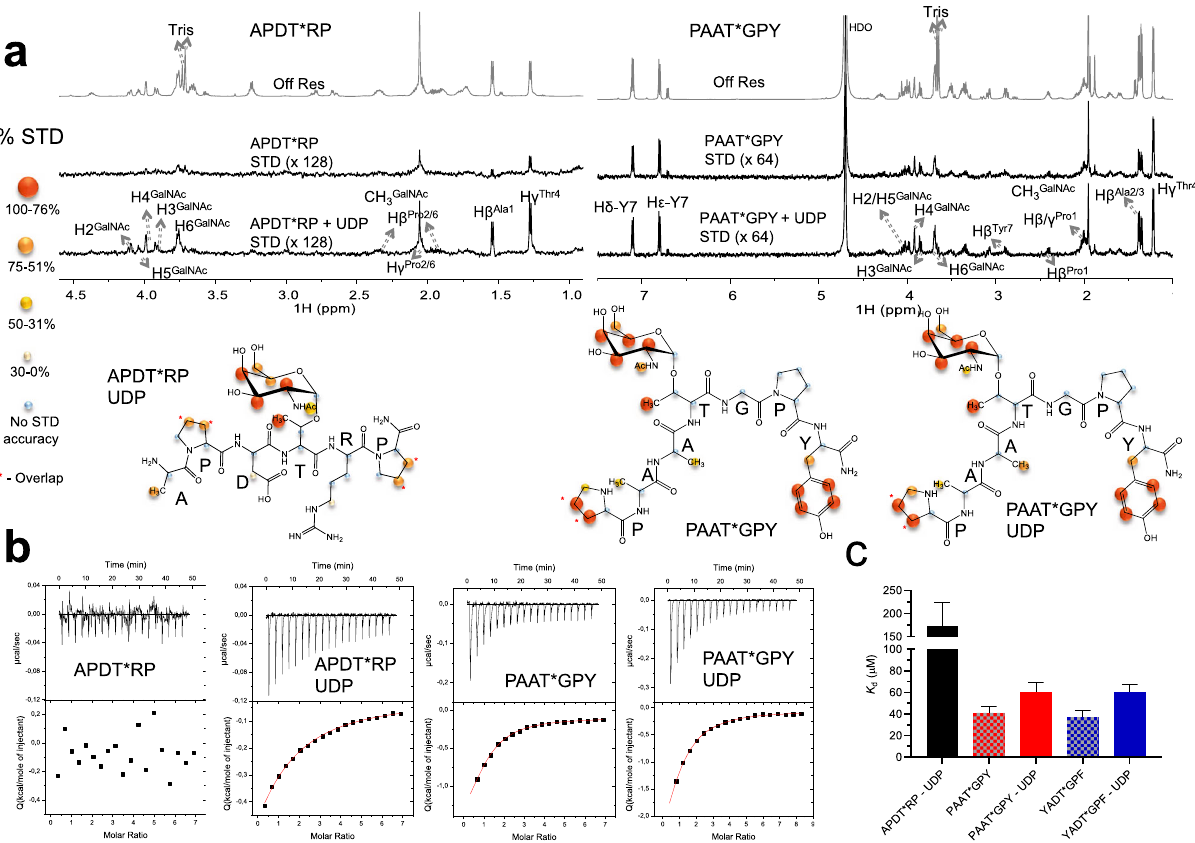
Fig. 2 STD NMR experiments and ITC experiments. a Off resonance (Off Res) and STD spectra of APDT*RP and P4 in the absence and presence of UDP (on resonance frequency at − 0.5 ppm) (upper panel). STD NMR-derived epitope mapping for APDT*RP and P4 (lower panel). The different colored spheres indicate the normalized STD signal (in %) observed for each proton. The proton resonances that overlap in the spectrum are identi fi ed in the fi gure and displayed with *. b ITC data for the binding of APDT*RP and P4 to Dm C1GalT1. Top: raw thermogram (thermal power versus time). Bottom: binding isotherm (normalized heats versus molar ratio). The ITCs for APDT*RP and P4 were performed in the absence and presence of an excess of UDP. All our ITCs thermograms have low Wiseman “ c ” -parameters (c < 1), explaining why the initial plateau is missing. Despite this, data reliability is still valid as previously described before 70,71 , and in particular the estimated K d s from the low Wiseman “ c ” -parameters are still reliable as the possible error in n estimation has almost no effect in the K a parameter a djustment. Note that the Wiseman “ c ” -parameter is the product of the receptor concentration and the association constant, K a 63 . The experiments were performed in duplicate ( n = 2 independent experiments). c Graph depicting the K d s for APDT*RP in the presence of UDP, and P4/P7 in the presence or absence of UDP. Error bars represent the error calculated through iteration fi t of the data sets by the